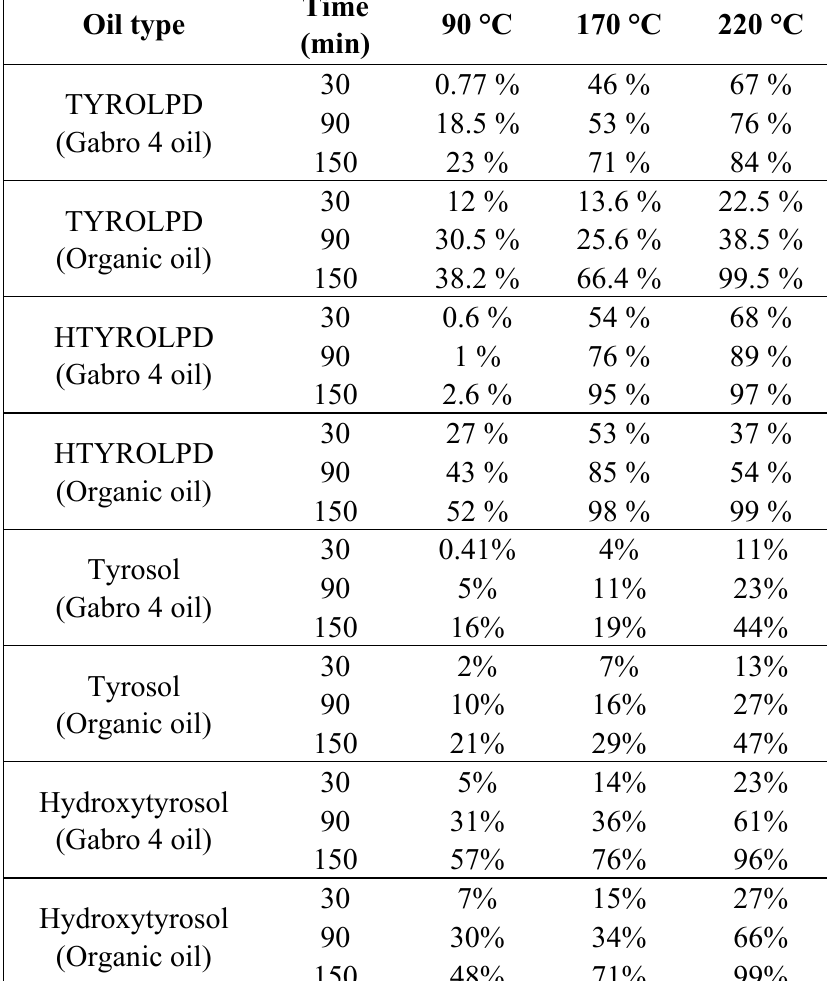
Table 1. % of TYROLPD, HTYROLPD, TYR, and HTYR losses in EVOO (Oil GABRO 4) and (Oil Bio) heated at 90 °C, 170 °C, and 220 °C.